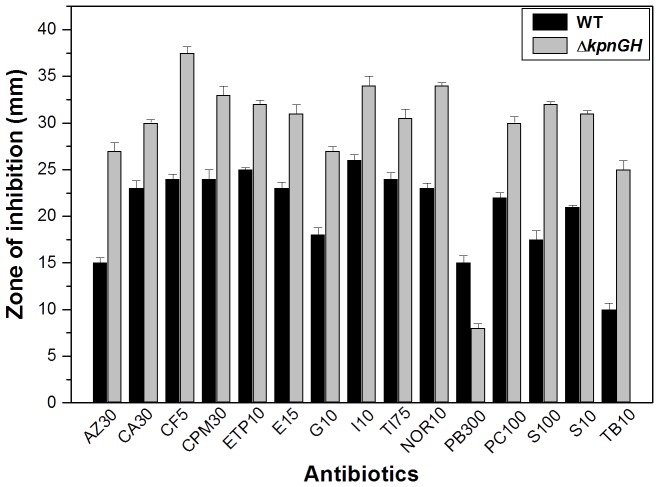
Antimicrobial Susceptibility assays.The Kirby Bauer disc diffusion assay was performed with different antibiotics using commercial discs. Data for representative drugs have been shown here.